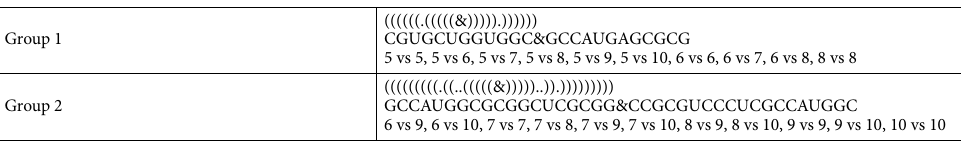
Table 3. Interaction groups across various human SBF1 (GCC)-repeats a . a Lengths with interaction structure and sequences in bracket-dot notation (matching parenthesis are opening and closing bases of a base pair, dots are unpaired bases, and separate the two interacting